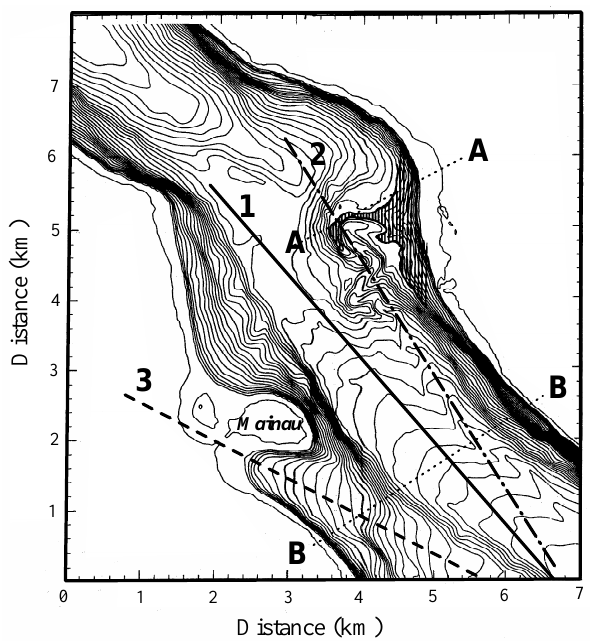
Fig. 1. Local bathymetric map of Lake Constance in the region of the Mainau Island. The contour interval equals 5m. Cross sections 1–3 show the selected directions of 2-D wave propagation.